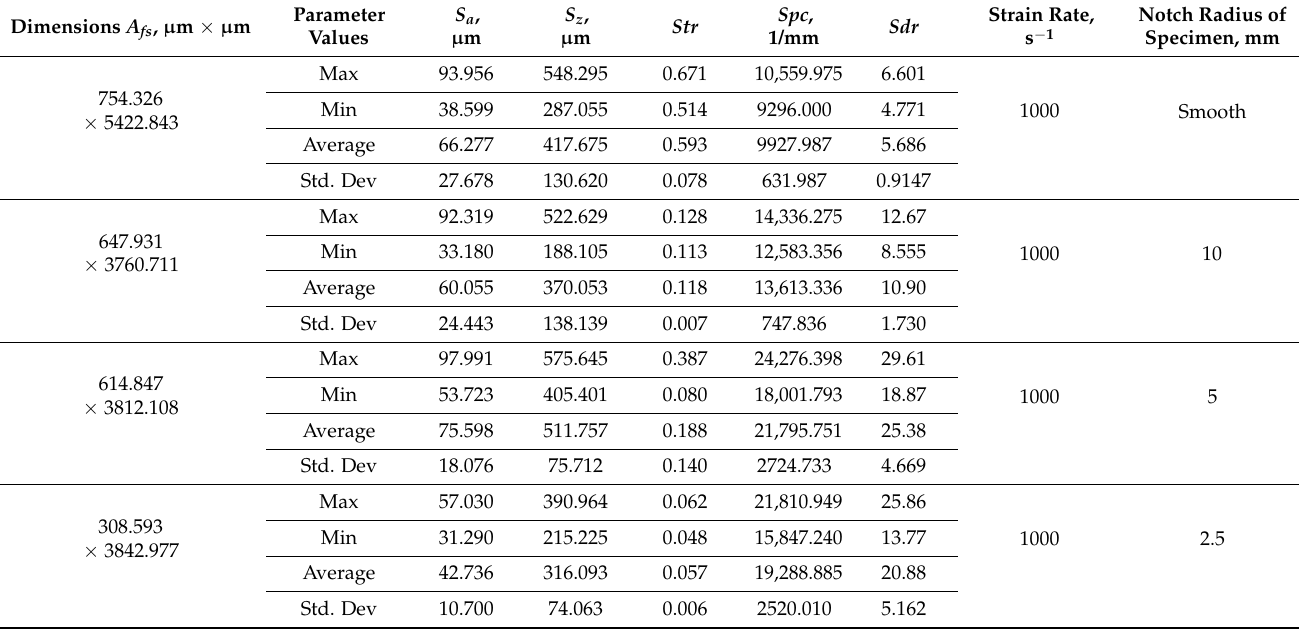
Table 1. Topological parameters of fracture surfaces of smooth and notched Ti-6Al-4V specimens after high-strain-rate tension. Parameter Dimensions A fs , µ m × µ m